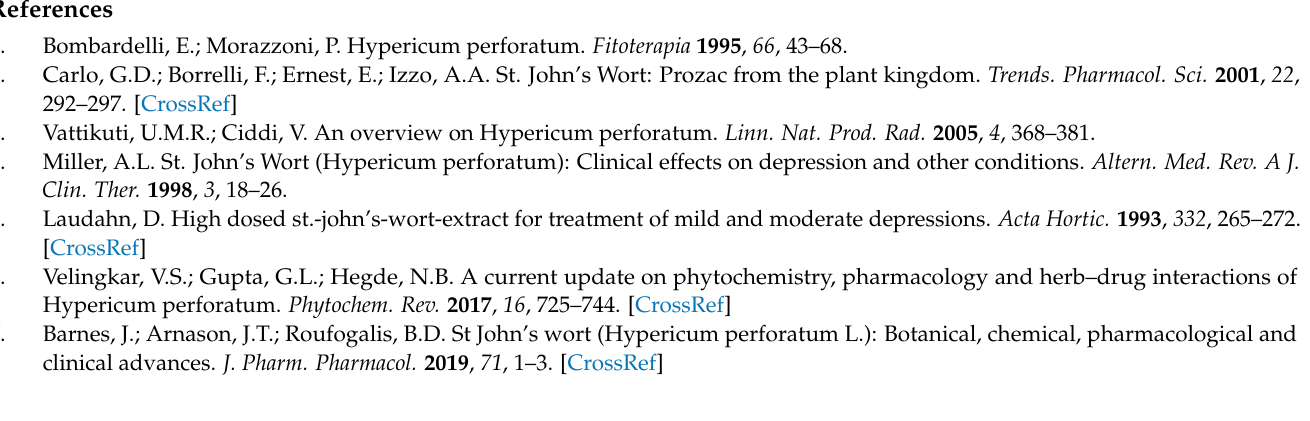
Figure S1: Length distribution of unigenes; Figure S2: Basic annotation for all unigenes; Figure S3: Top 10 plant species distribution of the total homologous sequences; Figure S4: Distribution of uni- genes in the transcriptome with KOG functional classification; Figure S5: Functional classifications of GO terms of all assembled unigenes; Figure S6: The PCA analysis between 15 and 22 ◦ C samples; Figure S7: The correlation analysis of heat map between 15 and 22 ◦ C samples; Figure S8: Number of differentially expressed genes and volcano plot when plants grown at 15 versus 22 ◦ C; Figure S9: The quality of total RNA at 15 and 22 ◦ C was evaluated by 1.0 % agarose gel electrophoresis. Table supplemental legends: Table S1: Sequences of primer employed in qRT-PCR analysis; Table S2: Sum- mary of sequencing data of H. perforatum transcriptome; Table S3: Database searches for collected H. perforatum nucleotide sequences; Table S4: Photosynthesis genes differentially expressed at 15 versus 22 ◦ C; Table S5: Carbohydrate metabolism genes differentially expressed at 15 versus 22 ◦ C; Table S6: Fatty acids metabolism genes differentially expressed at 15 versus 22 ◦ C; Table S7: Cytochrome P450 genes differentially expressed at 15 versus 22 ◦ C; Table S8: Morphophysiological traits genes differentially expressed at 15 versus 22 ◦ C; Table S9: Heat shock protein and cold responsive protein genes differentially expressed at 15 versus 22 ◦ C and Table S10: Transcription factors differentially expressed at 15 versus 22 ◦